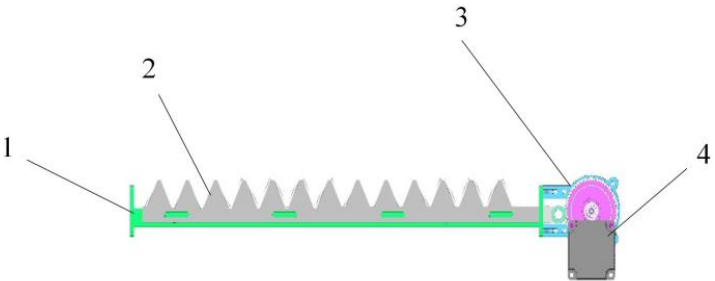
Figure 1. The structure drawing of the reciprocating cutter system: 1 — cutter holder; 2 — cutter; 3 — transmission mechanism; 4 — motor.